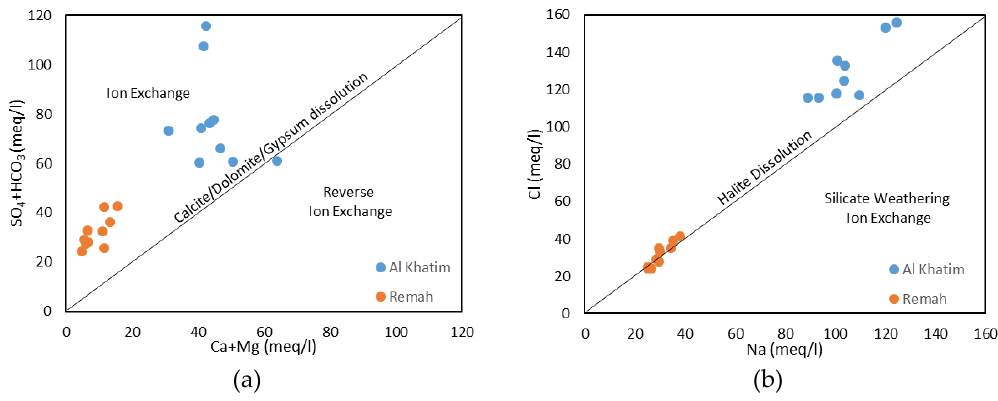
Figure 14. ( a ) Ca + Mg versus SO 4 + HCO 3 ; ( b ) Na versus Cl plot for Remah and Al